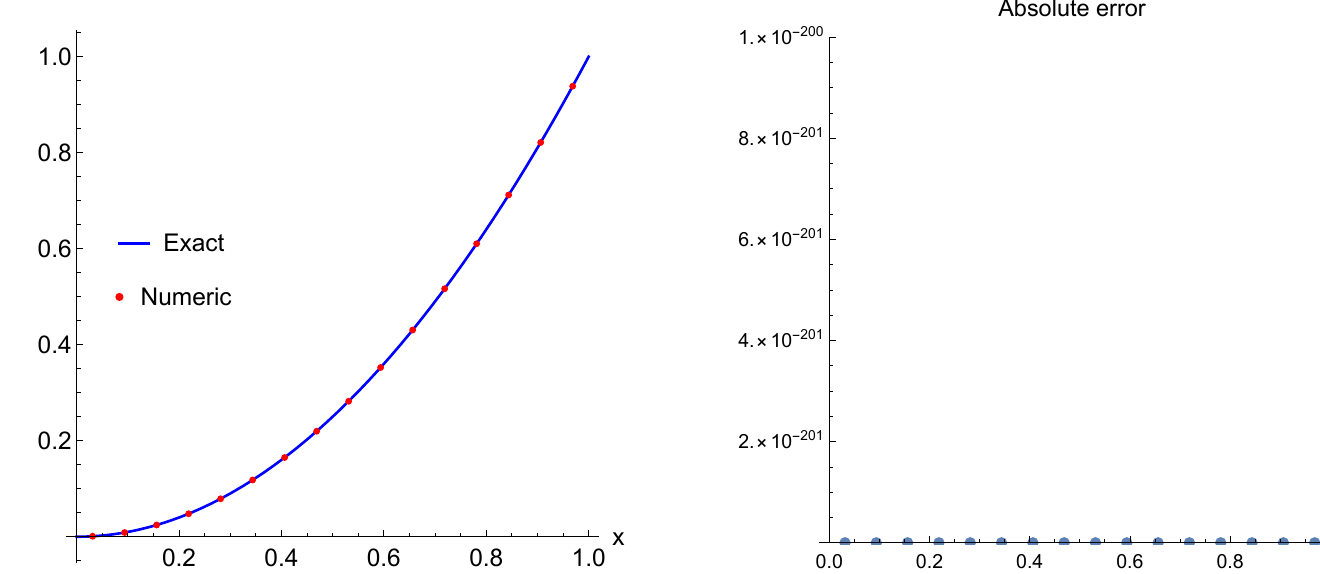
Figure 11. The numerical solution (points) with exact solution ( left ) and the absolute error computed for Example 8 ( right ).